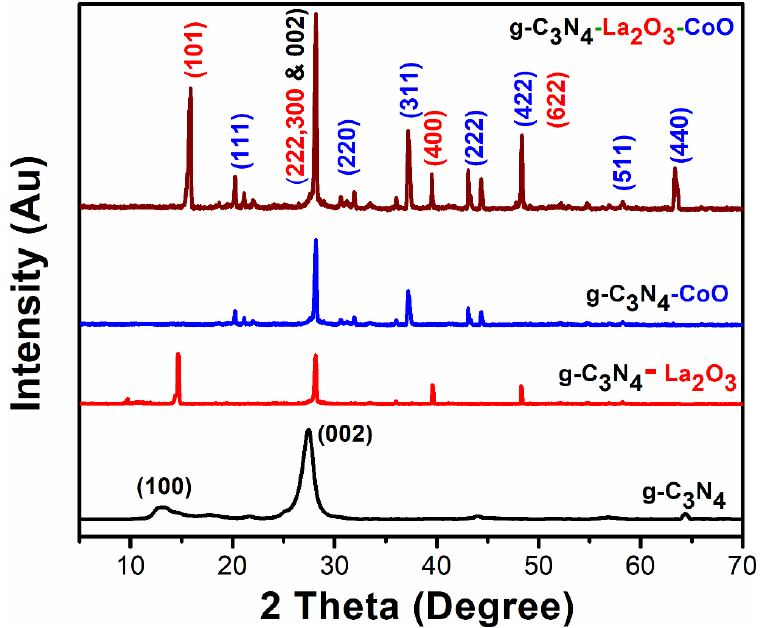
Figure 1. The XRD analysis of g-C 3 N 4 , g-C 3 N 4 –CoO, g-C 3 N 4 –La 2 O 3 , and La 2 O 3 –CoO–g-C 3 N 4- Nano-